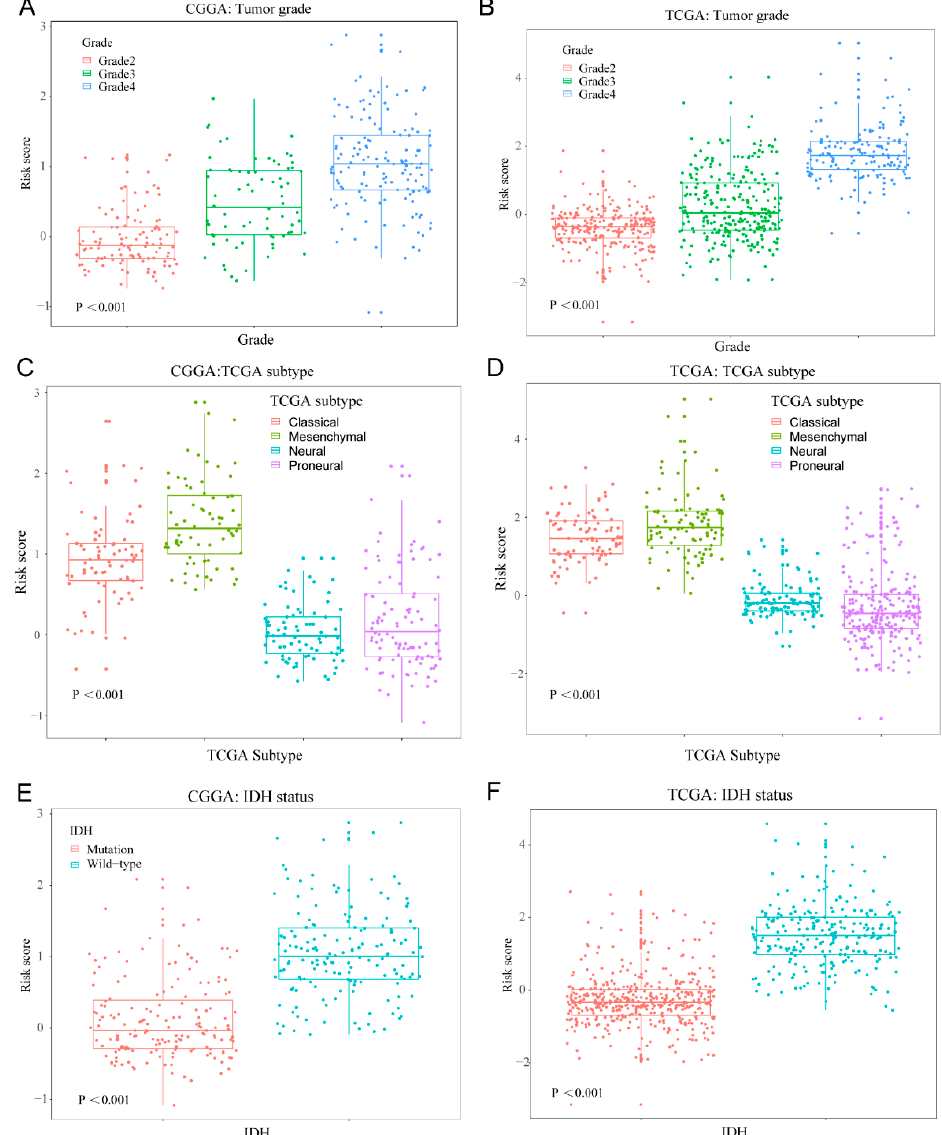
Figure 3. The 10-gene risk signature distinguished the clinicopathological features of gliomas. Distribution of the 8-gene risk signature with different tumor grades ( A , B ), TCGA subtypes ( C , D ) and IDH status ( E , F ).